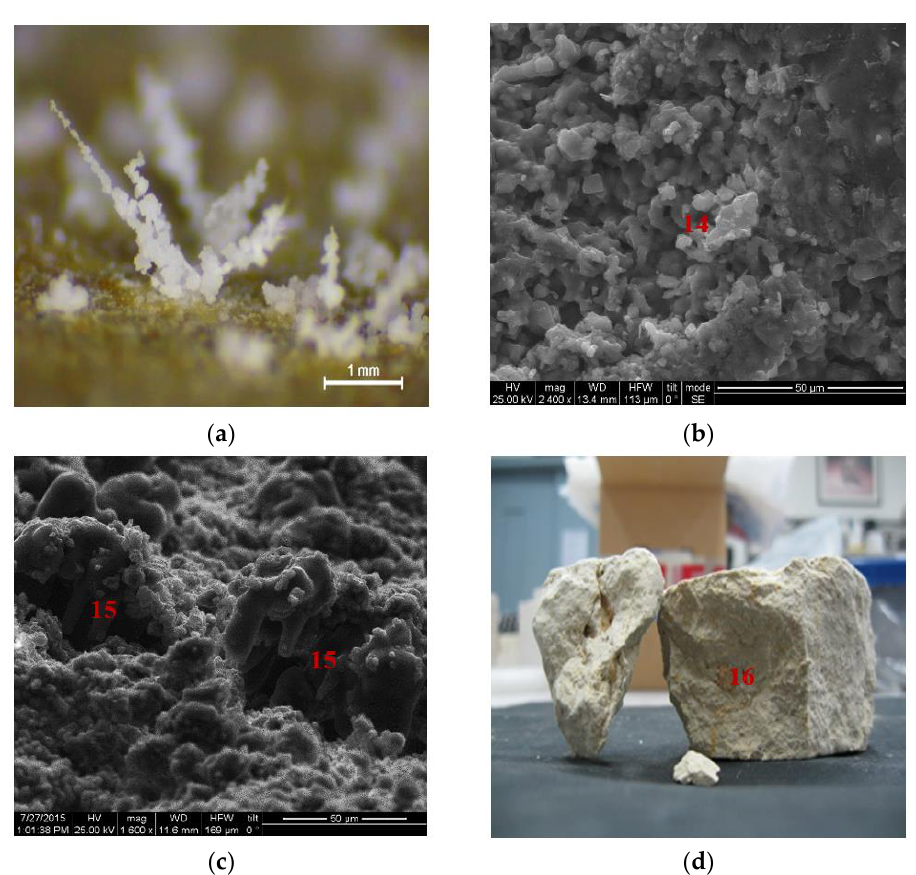
Figure 10. Microstructural and petrographic characteristics of the seven untreated stone samples in ( a ) salts attributed to occurrence of efflorescence on the stone surface (Stereomicroscope, scale bar at 1 mm); ( b ) deposition of NaCl crystallization causing eventually the appearance of cracking phenomena (SEM microphotographs, scale bar at 50 μm); ( c ) mechanical damage due to NaCl crystallization causing efflorescence (SEM microphotographs, scale bar at 50 μm) and ( d ) cracking of the stone specimen attributed to the synergetic effect of rich alumino-silicatic composition and accelerating ageing tests.